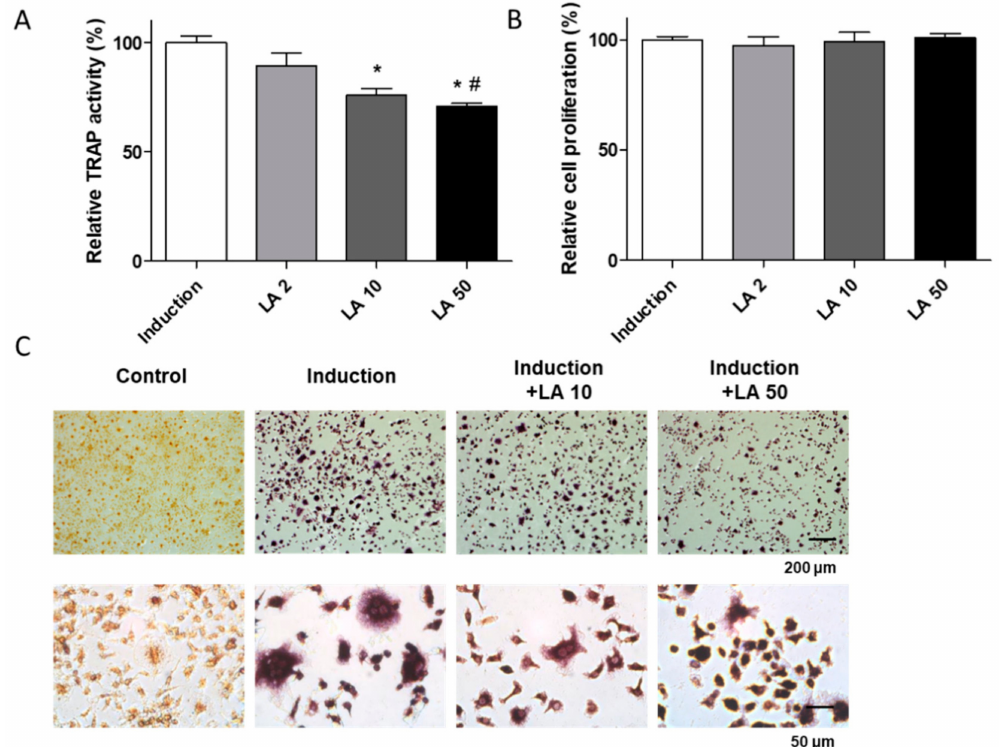
Figure 6. The effects of loganic acid on osteoclast differentiation. Primary-cultured monocytes from mouse femoral bone were co-incubated with osteoclast induction media (30 ng/mL of M-CSF and 50 ng/mL of RANKL) and different concentrations of loganic acid (2, 10, and 50 µ M) for 5 days. ( A ) TRAP activity was assessed using an Acid-Phosphatase Kit. LA: loganic acid, Induction: osteoclast induction media-treated group. * p < 0.05 vs. Con, # p < 0.05 vs. LA2 (ANOVA with Tukey’s honest significant difference post hoc test). ( B ) Relative cell proliferation was evaluated by water-soluble tetrazolium (WST) assay. ( C ) TRAP-positive cells were stained and visualized by a light